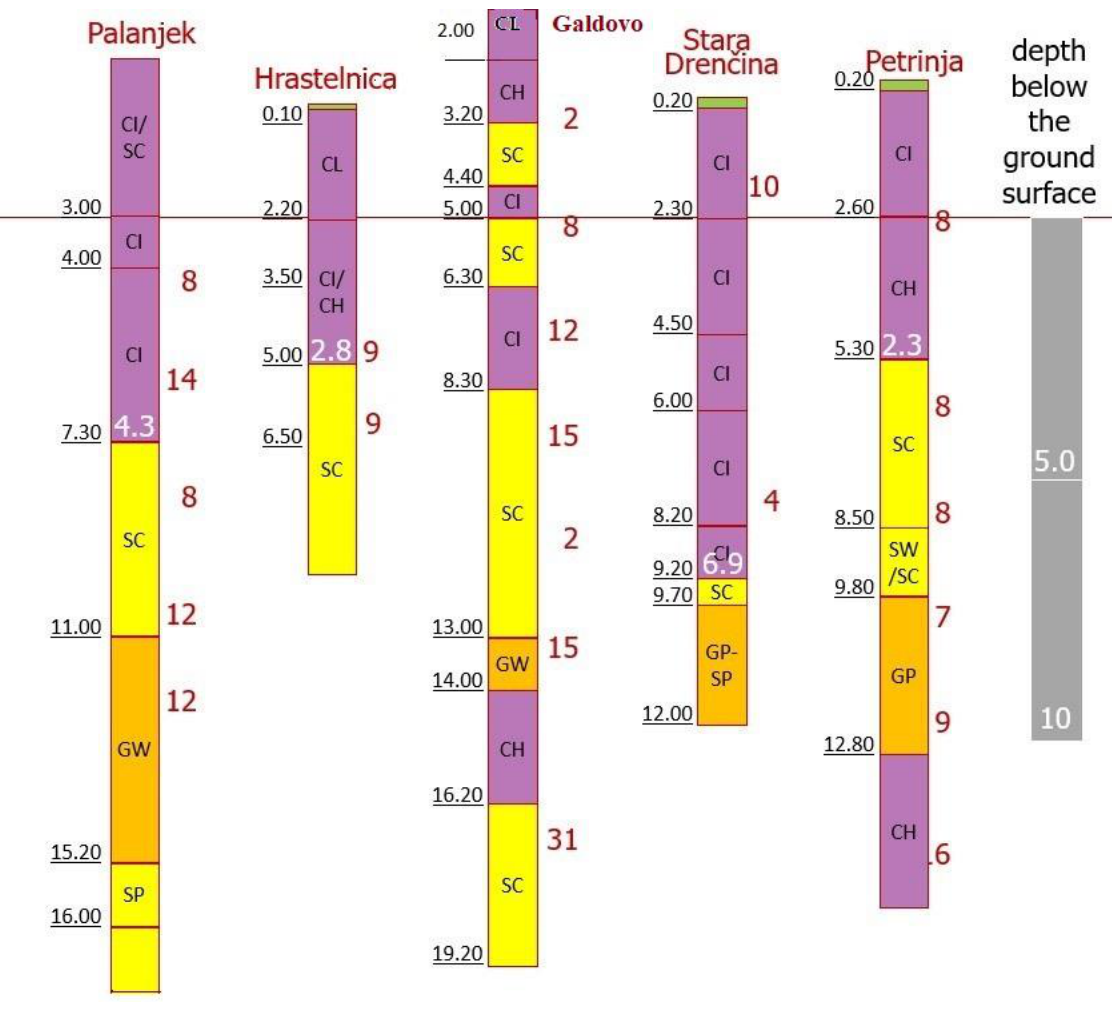
Figure 5. Some of the geotechnical data on the discussed damaged sections. White numbers show the depth of the sandy layer below the ground surface — in the figure shown as a red line. Surface layers are clays of intermediate or high plasticity, presented in violet colour; sand with a high content of clay or silt is present at depths of several metres, presented in yellow. The number of SPT blows before the earthquake are shown as red numbers on the right.